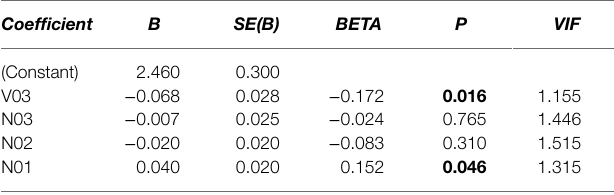
TABLE 6 | Multiple regression with ECL and cognitive abilities ( n = 222).